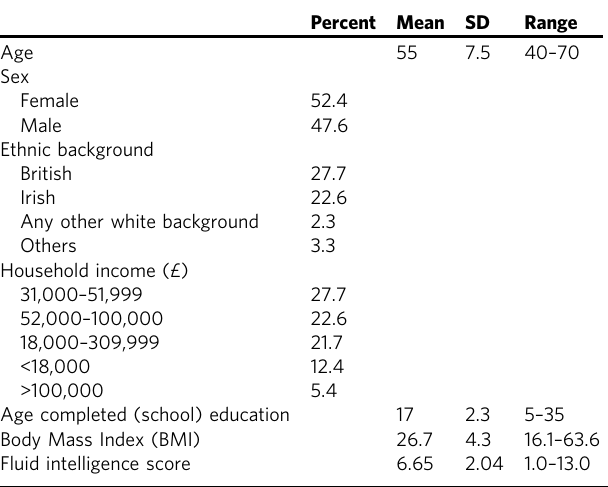
Table 1 UK Biobank demographic